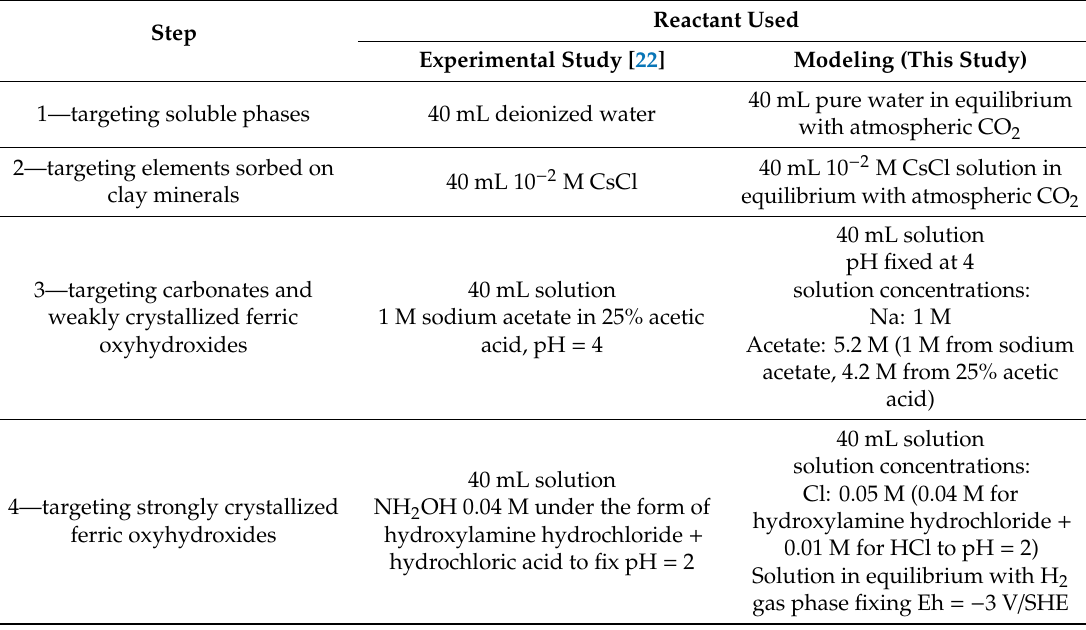
Table 1. The four steps of the sequential extraction protocol and the reactants used in each step by the experimental (Chautard et al. [22]) and modeling work (this